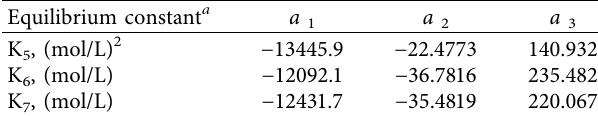
Table 1: Pseudo-equilibrium constants.